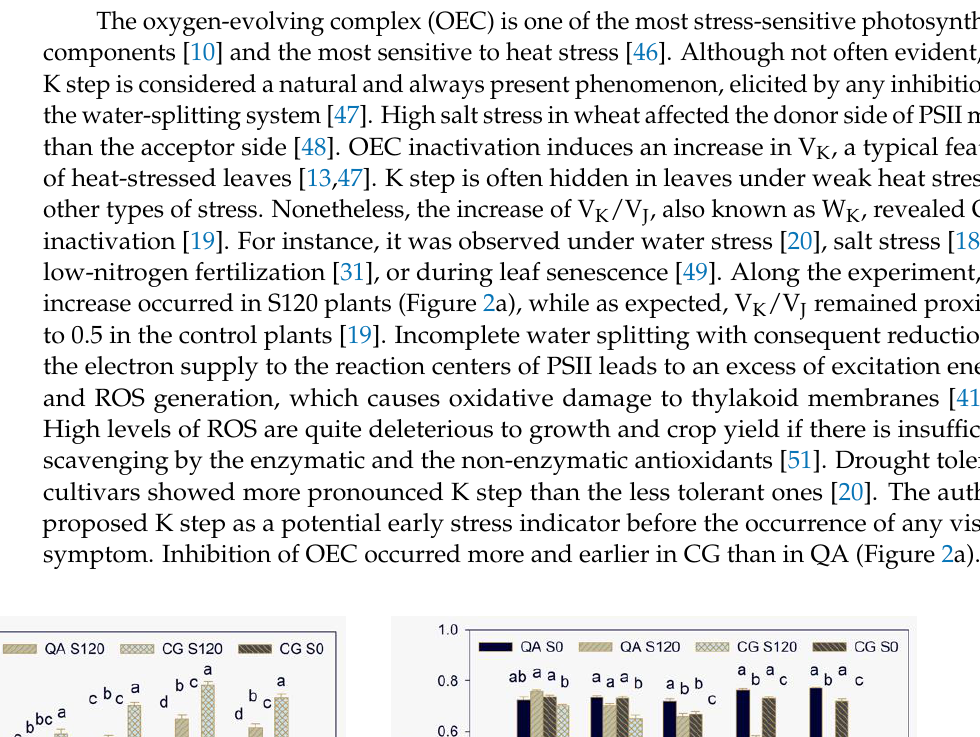
( b ) Figure 1. Polyphasic rise of relative variable fluorescence (V t ) upon illumination with saturating light of dark-adapted